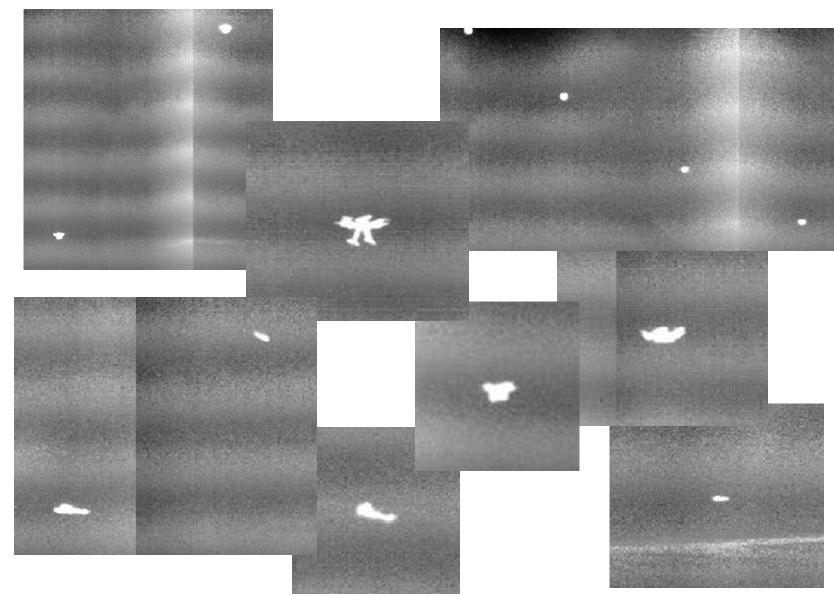
Figure 6. Examples of rotary and fixed UAVs captured by a thermal